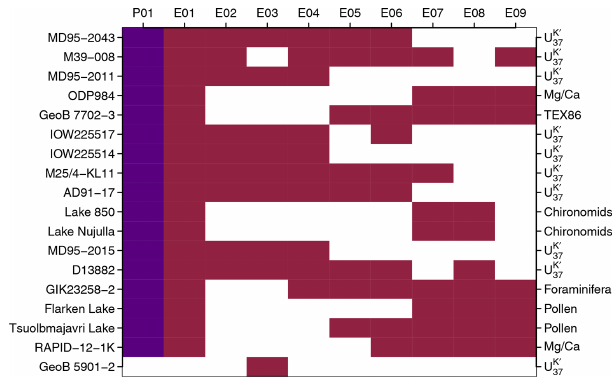
Figure 3. Information about the different proxy setups: matrix of proxy records against proxy setup (P01, indigo, and E01 to E09, burgundy red). For more information, see Table 1. Whited-out ar- eas indicate that the relevant proxy is not included in the respective proxy setup. Note that the pseudo-proxy setup (P01) does not dis- tinguish between proxy types and uses only approximate locations due to the discrete simulation